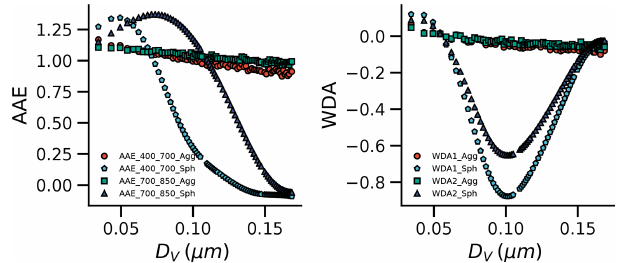
Figure 6. Comparison of AAE and WDA between BC sphere and aggregates ( D f =1.8, m = 1 . 95 + 0 . 79 i ). Here WDA1 represents the AAE difference between the 400–700nm wavelength pair and the 700–850nm wavelength pair; WDA2 represents the difference be- tween the 400–850nm wavelength pair and the 700–850nm wave- length pair. “Agg” and “Sph” denote the fractal BC aggregates and spherical BC, respectively.